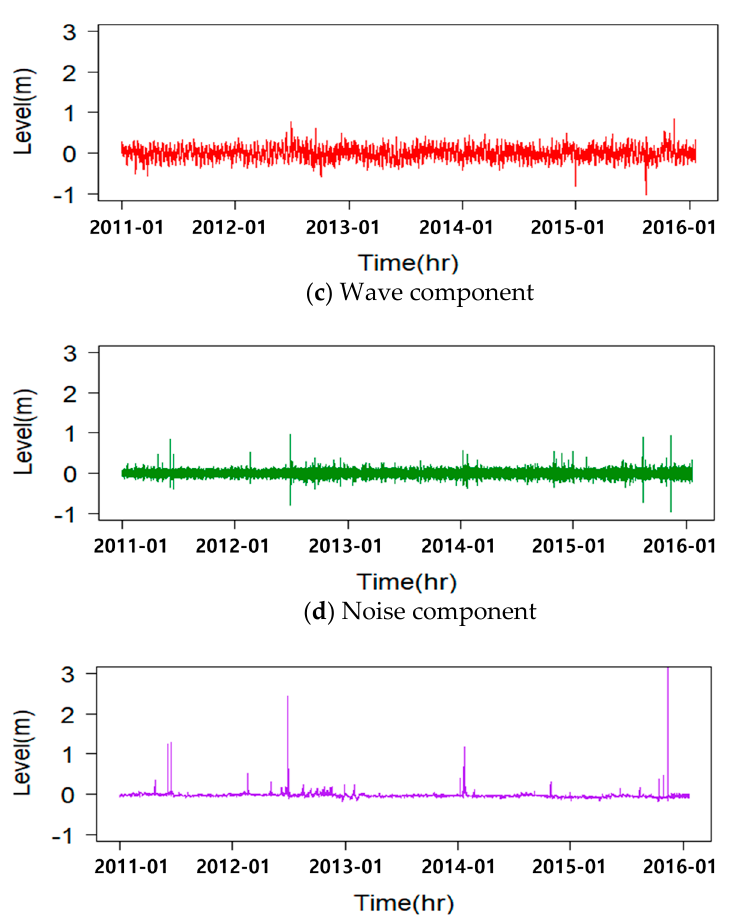
Figure 9. Separation results for the stream water level series.